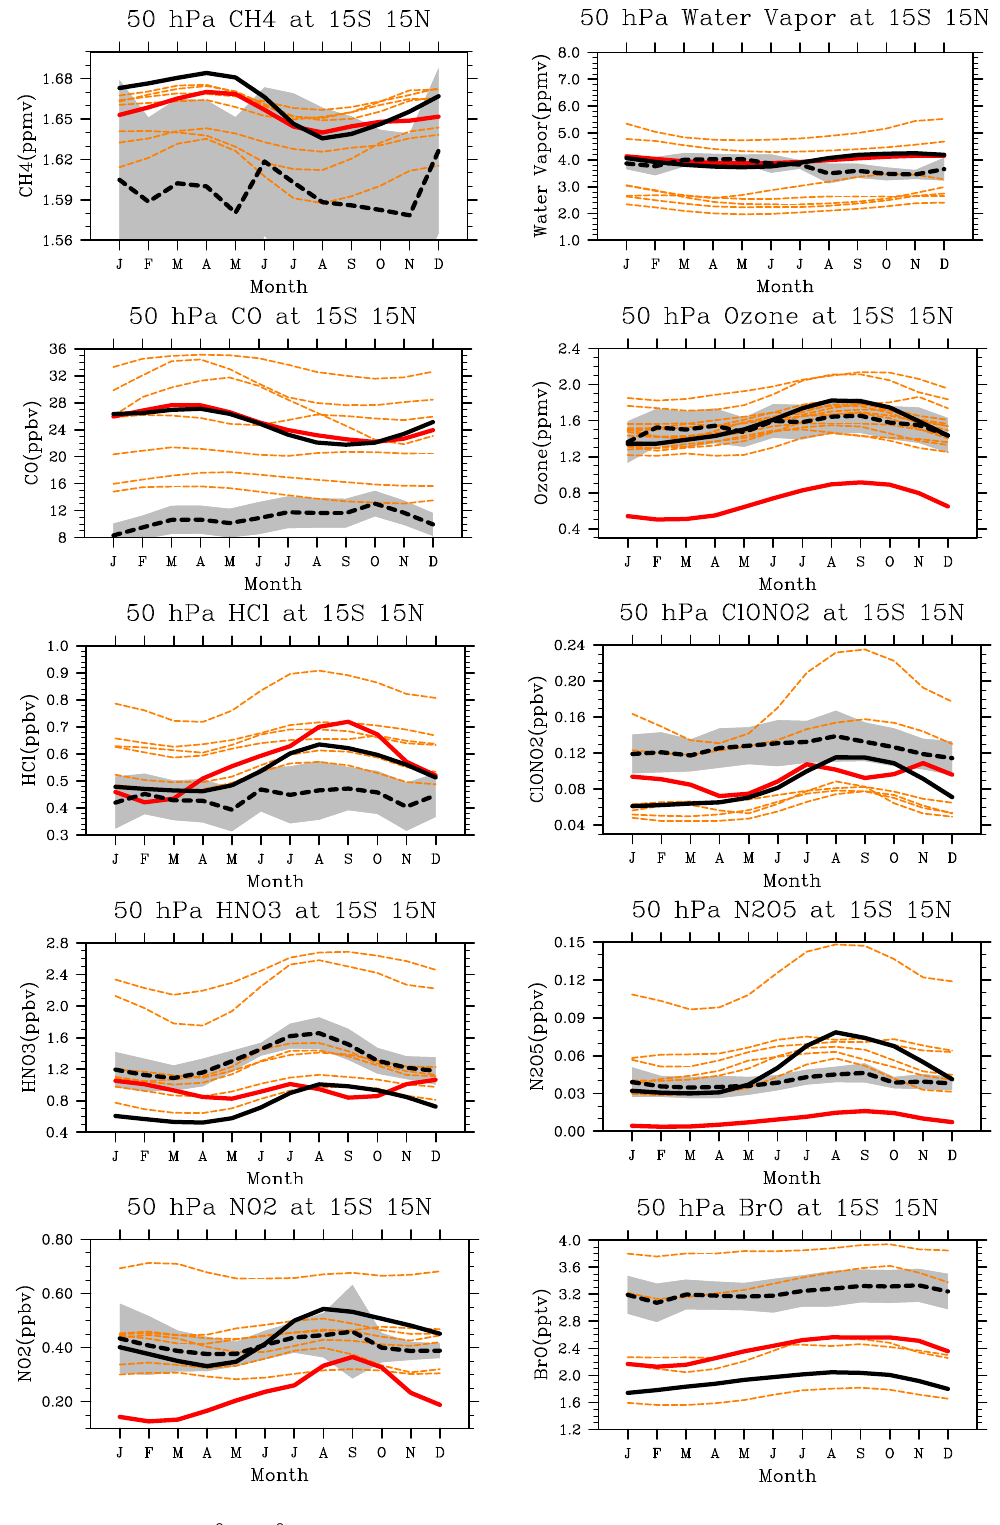
Fig. 14. Same as Fig. 12 at 50 hPa , 15 ◦ S–15 ◦ N.